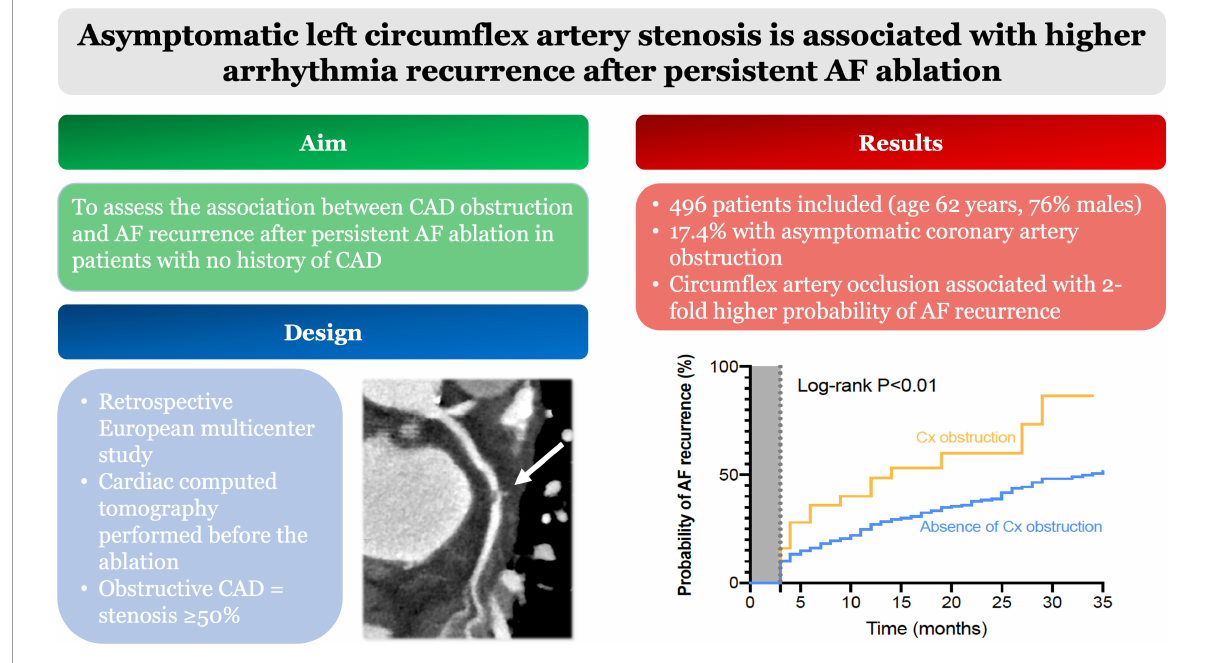
FIGURE3 Central illustration. In total, 496 patients had CCT before persistent AF ablation. Among them 17.4% had coronary obstruction. Circumflex artery occlusion was associated with a 2-fold higher probability of AF recurrence during follow-up. Abbreviations: AF, atrial fibrillation; CCT, cardiac computed